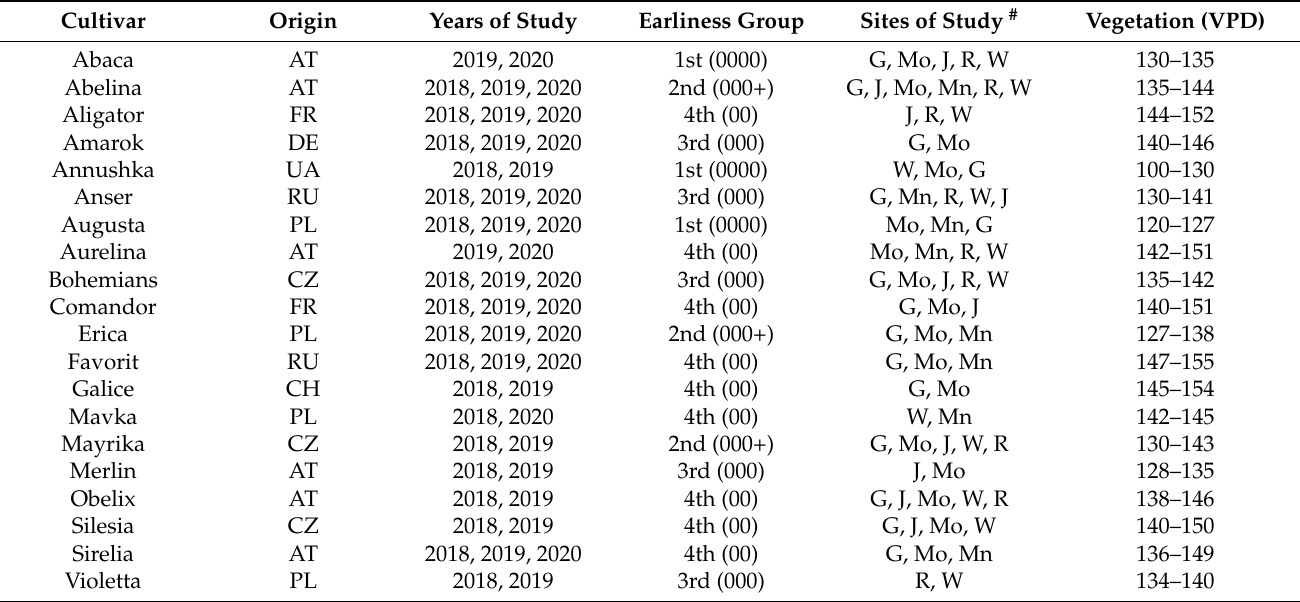
Table 2. Cultivar characteristics in alphabetic order used in the